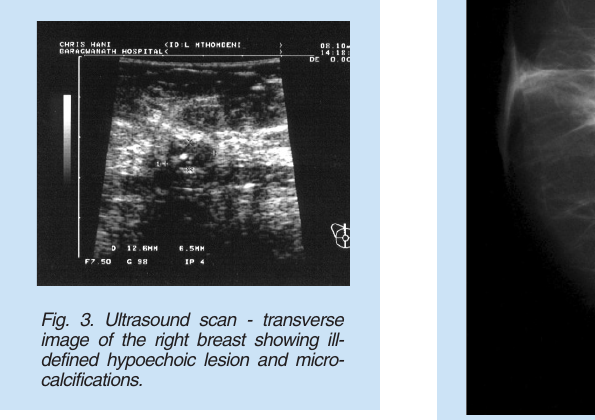
Fig. 2b. Mammogram showing patchy spicu- lated